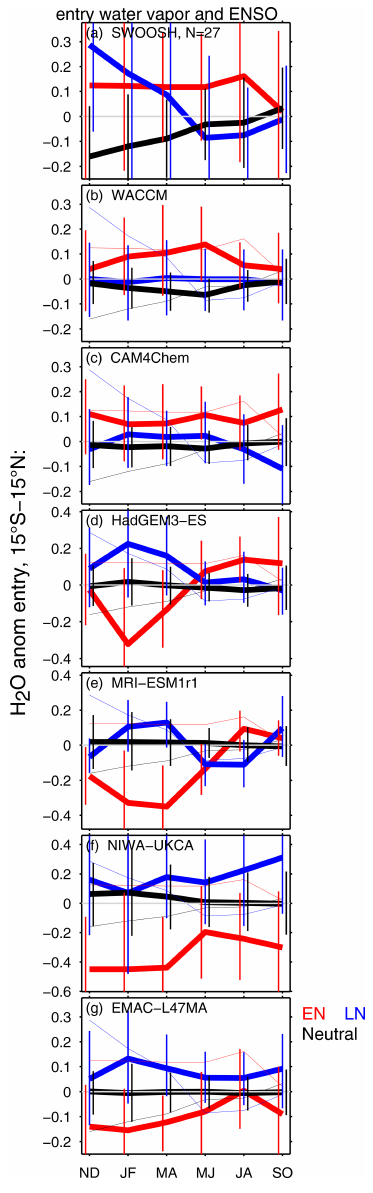
Figure 5. (a) As in Fig. 2a but for SWOOSH at 82hPa. (b–g) As in Fig. 2 but subsampling the model output for each model to match the sample size in observations for each ENSO phase. The uncer- tainty (marked with vertical lines) of the model response is deter- mined by Monte Carlo subsampling, as described in the text. The response in Fig. 2a is repeated with a thin line in subsequent